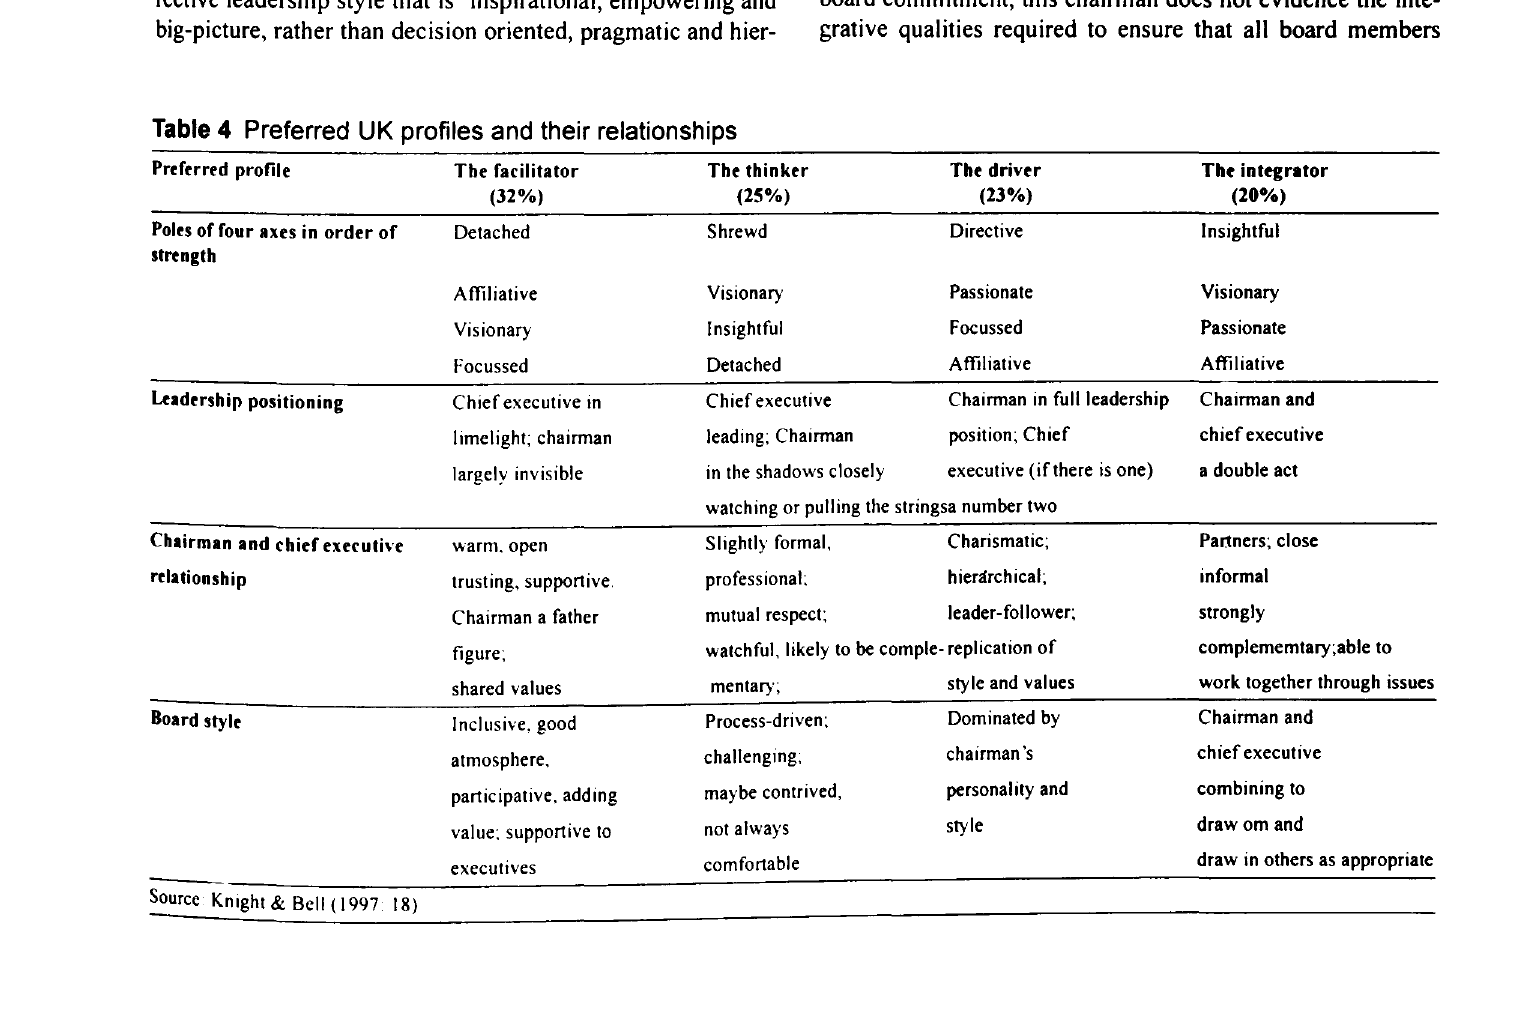
Preferred profile Poles of four axes in order of